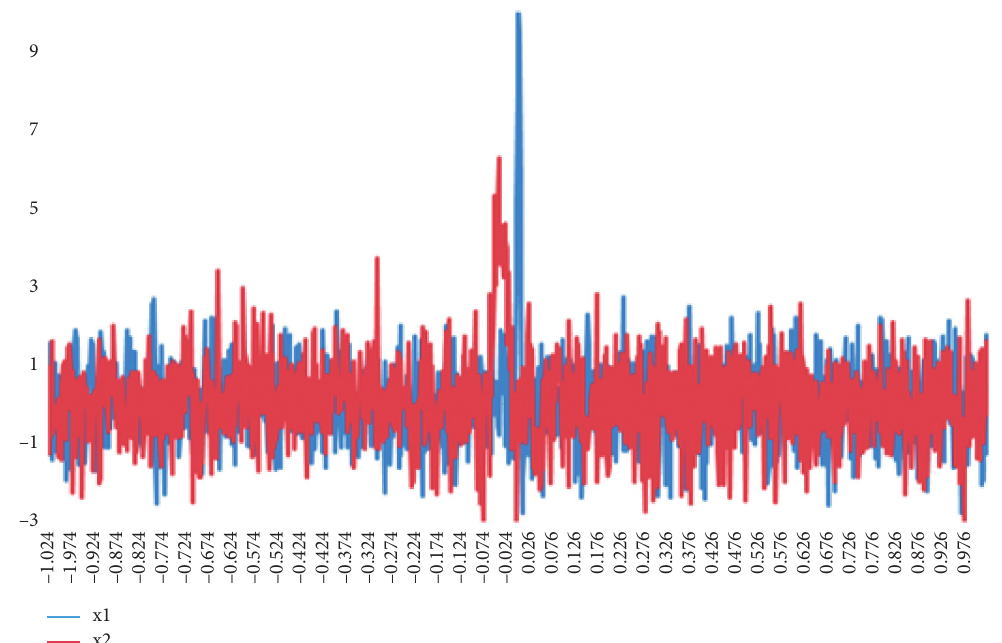
Figure 6: Illustration of the signal with added noise ( σ � 1).